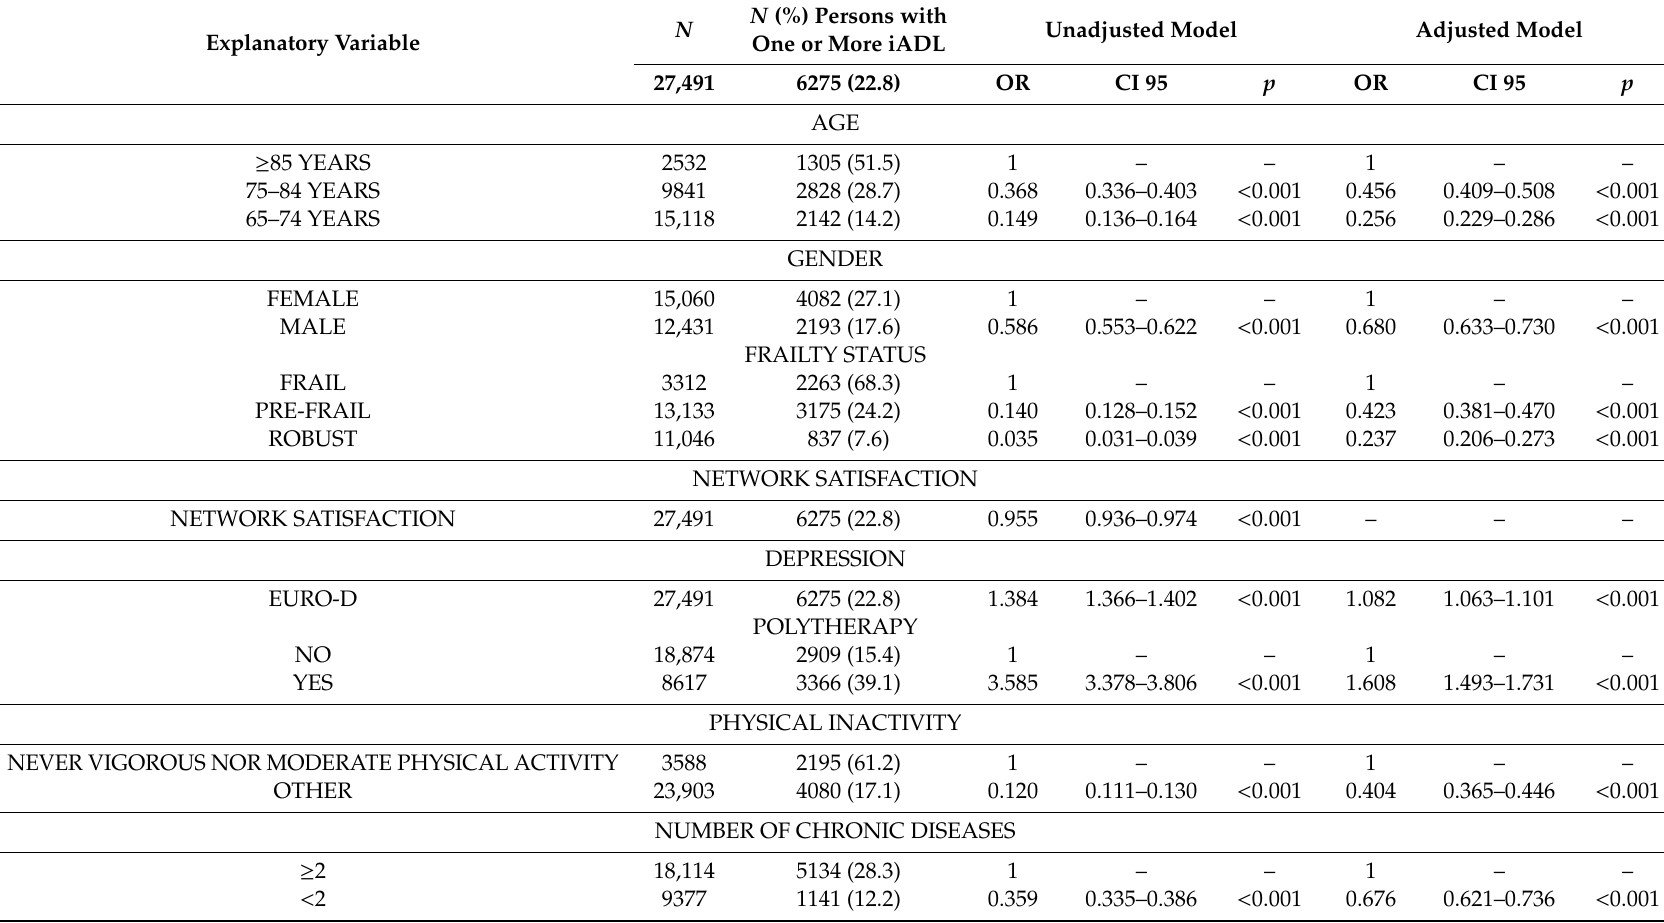
Table 3. Unadjusted and Adjusted Model. Association of all explanatory variables with one or more iADLs. iADLs (Instrumental activities of daily living); BMI (Body Mass